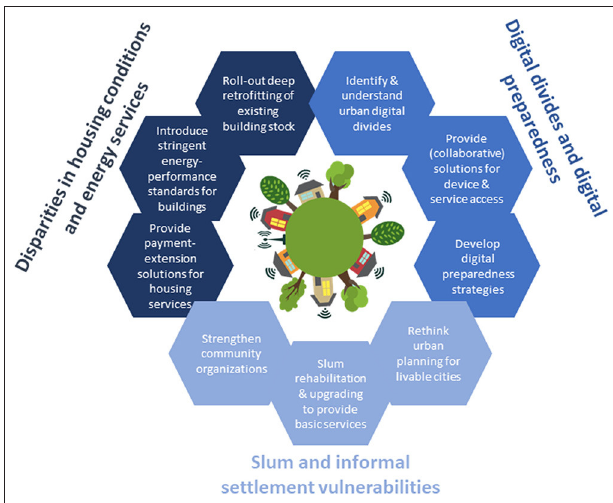
FIGURE 1 | Select mid- to long-term recommendations for future cities under a COVID-19